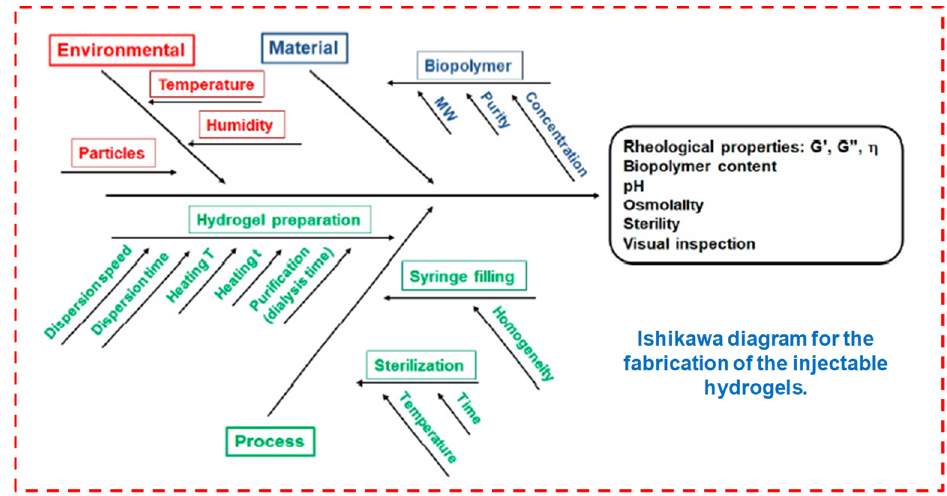
Figure 4. Fabrication of injectable hydrogels. Reprinted with permission from ref. [9]. Copyright © 2021 Polymer MDPI.